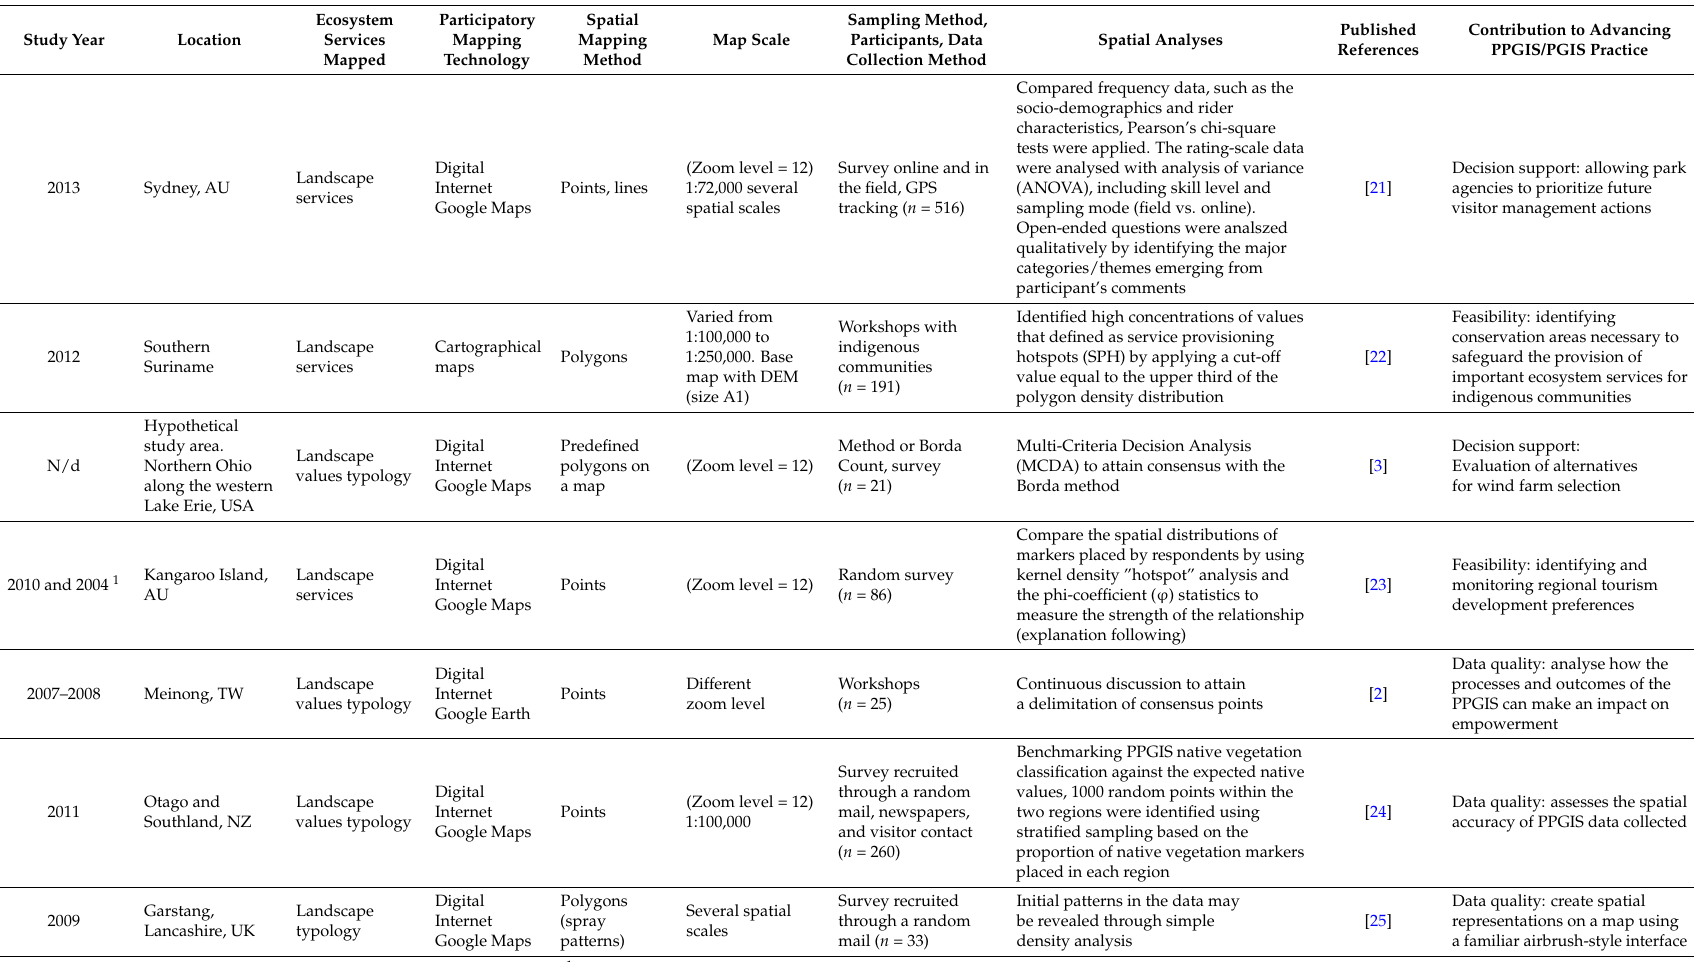
Table 1. Updated (2009–2015) of the empirical PPGIS/PGIS studies for mapping ecosystem services from Greg Brown and Fagerholm [9] up to 1 December